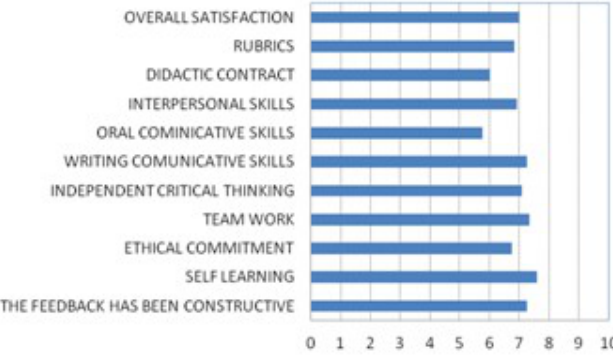
Figure 5. Results of student satsfacton survey (average